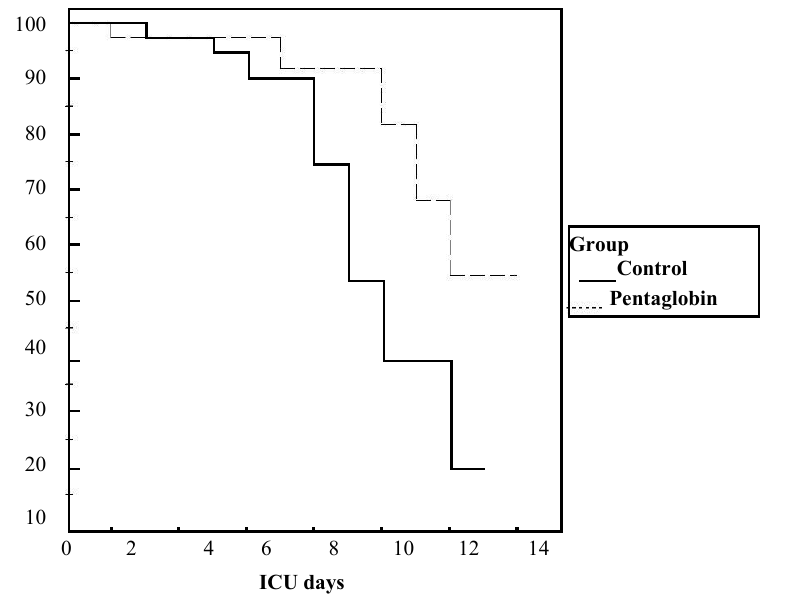
Figure 2. Kaplan-Meier survival